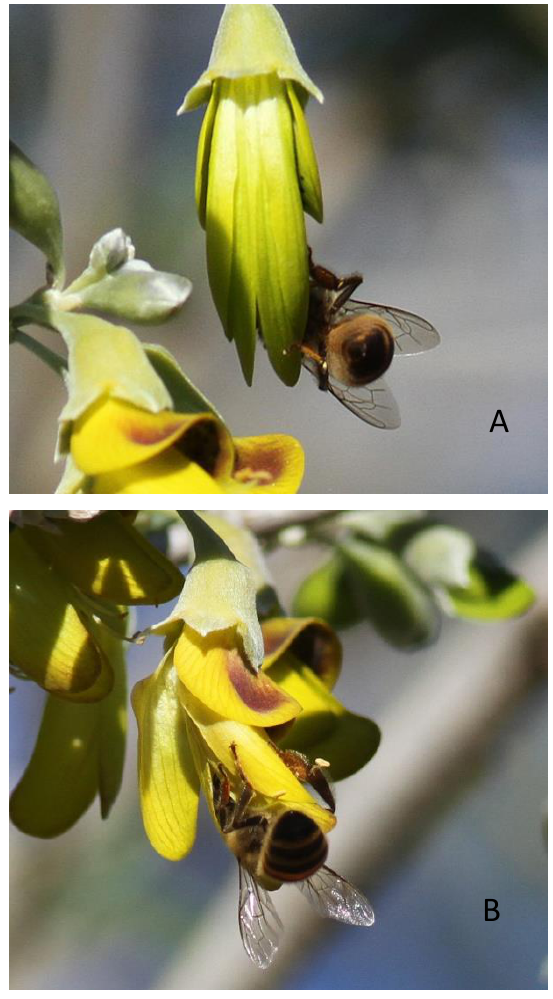
F IGURE 4. Honey bees foraging pollen of A. foetida. (A) Trying to open the keel. (B) Inside the keel.